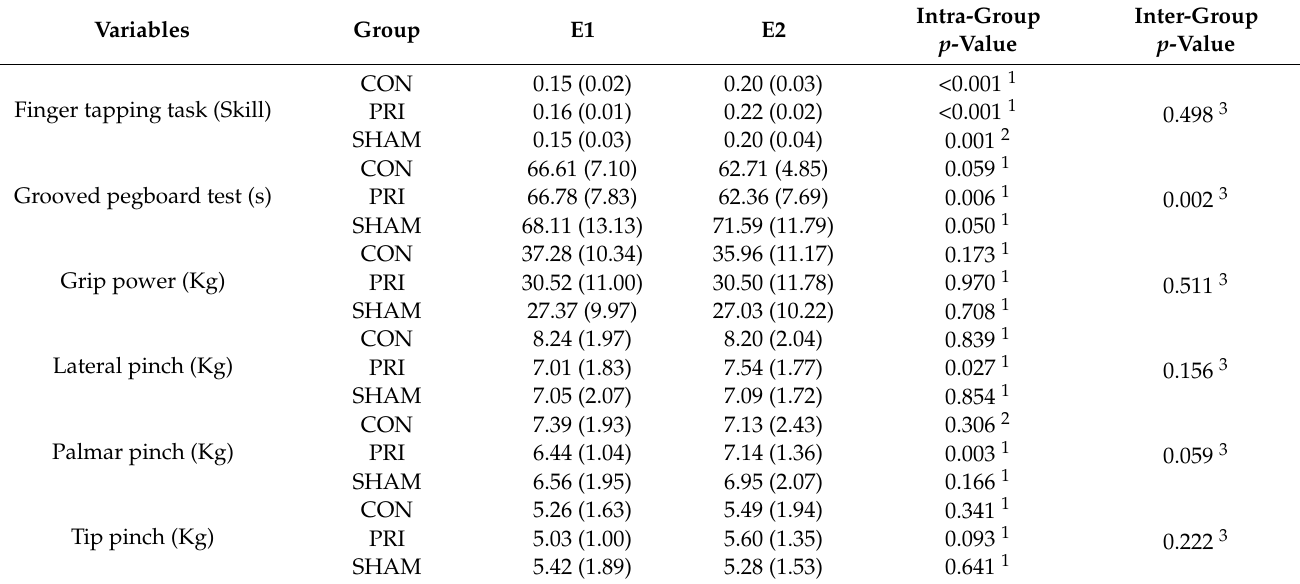
Table 2. Motor task performance. Data are presented as frequencies (%) and means (standard deviations, SD). Variables Group Finger tapping task (Skill)